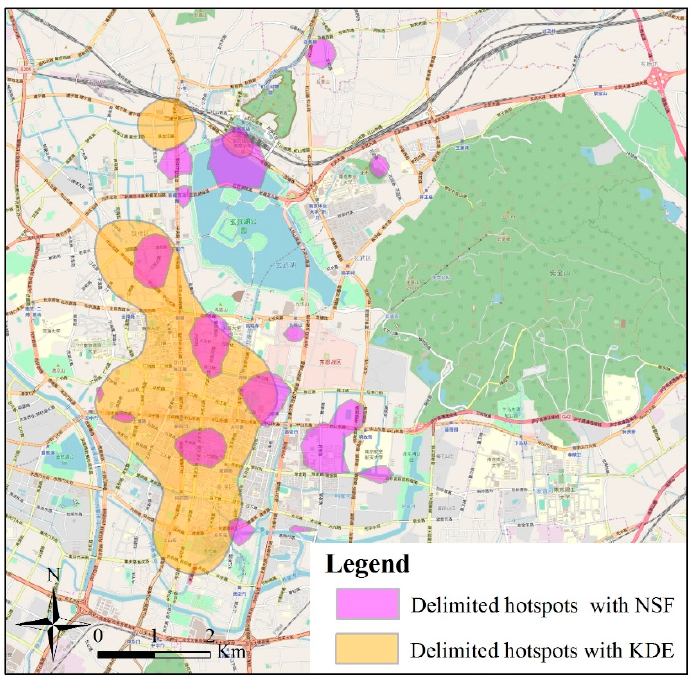
Figure 11. The delineated hotspots produced by the two standard deviations isolines of the NSF and KDE methods.